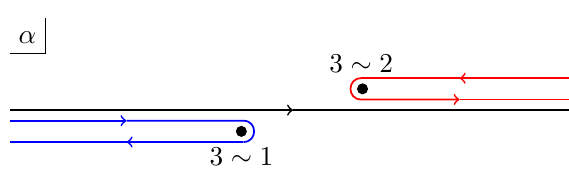
Figure 6. Contour prescriptions for the (cid:11) integral in the light transform of a three-point func- tion (2.60). The black contour corresponds to h (cid:10) jO 1 L [ O 3 ] O 2 j (cid:10) i , the blue contour corresponds to h (cid:10) j [ O 1 ; L [ O 3 ]] O 2 j (cid:10) i , and the red contour corresponds to h (cid:10) jO 1 [ L [ O 3 ] ; O 2 ] j (cid:10) i